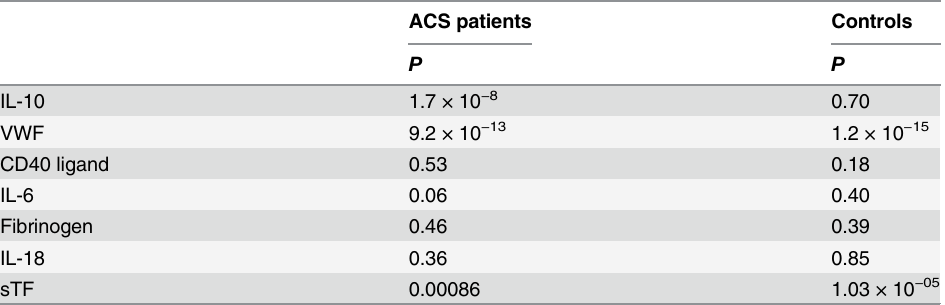
Table 7. Haplotype score statistics for the ABO antigens and all biomarkers using an additive model.